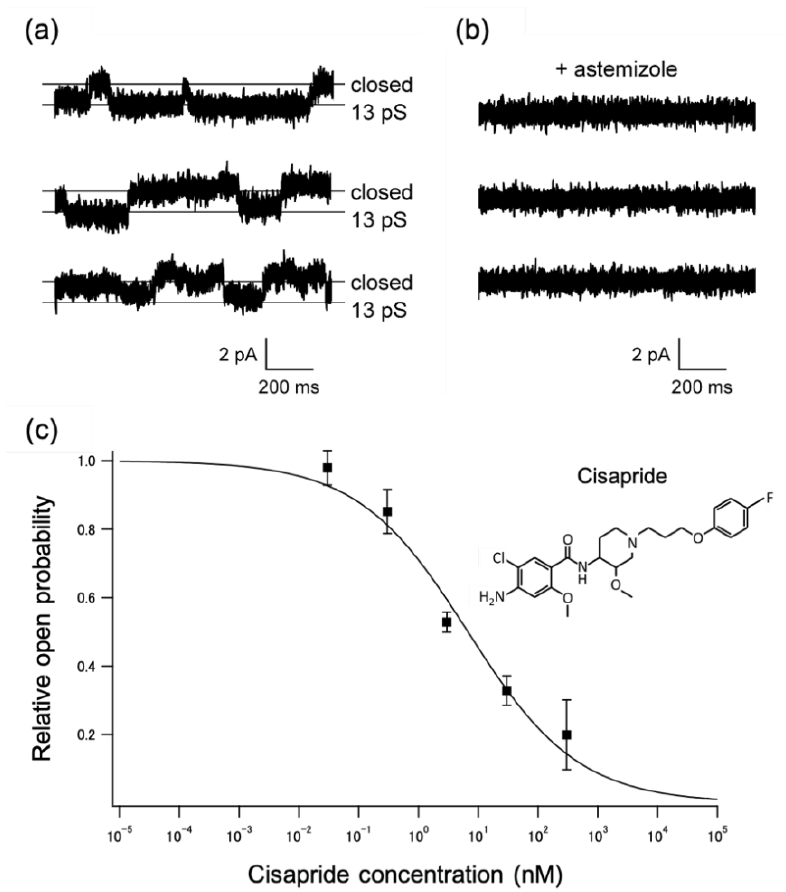
Figure 4. Examples of single-channel currents observed with BLMs containing cell-free synthesized wild-type hERG channels. All the currents were recorded at − 100 mV after a 300 ms prepulse of +50 mV. ( a ) Typical single-channel currents; ( b ) current traces after the addition of astemizole (1 µM); ( c ) relationship between cisapride concentration and relative open probability of the cell-free synthesized hERG channels. Lipid composition was L- α -phosphatidylcholine (PC):L- α -phosphatidylethanolamine (PE):cholesterol = 7:1:2 (weight ratio). A symmetric buffer containing 120 mM KCl and 10 mM HEPES (pH 7.2 in KOH) was used in these experiments. Current signals were filtered at 1 kHz with a low -pass Bessel filter and digitized at 10 kHz . The current data were offline filtered at a cut- off frequency of 0.7 kHz. Proteoliposomes containing the hERG channels were added to one side ( cis ) of the BLMs, and drugs were added to the other side ( trans ). Applied potentials were defined as the potential at the cis side relative to the trans side held at the ground. Reprinted with permission from refs. [6,12]. Copyright 2020 WILEY.